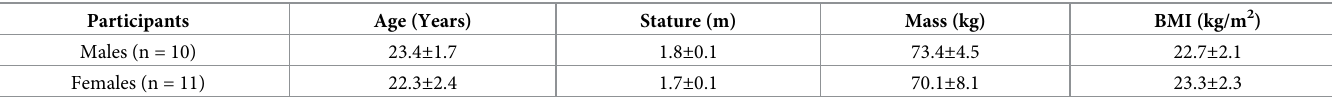
Table 1. Participants recruited for this